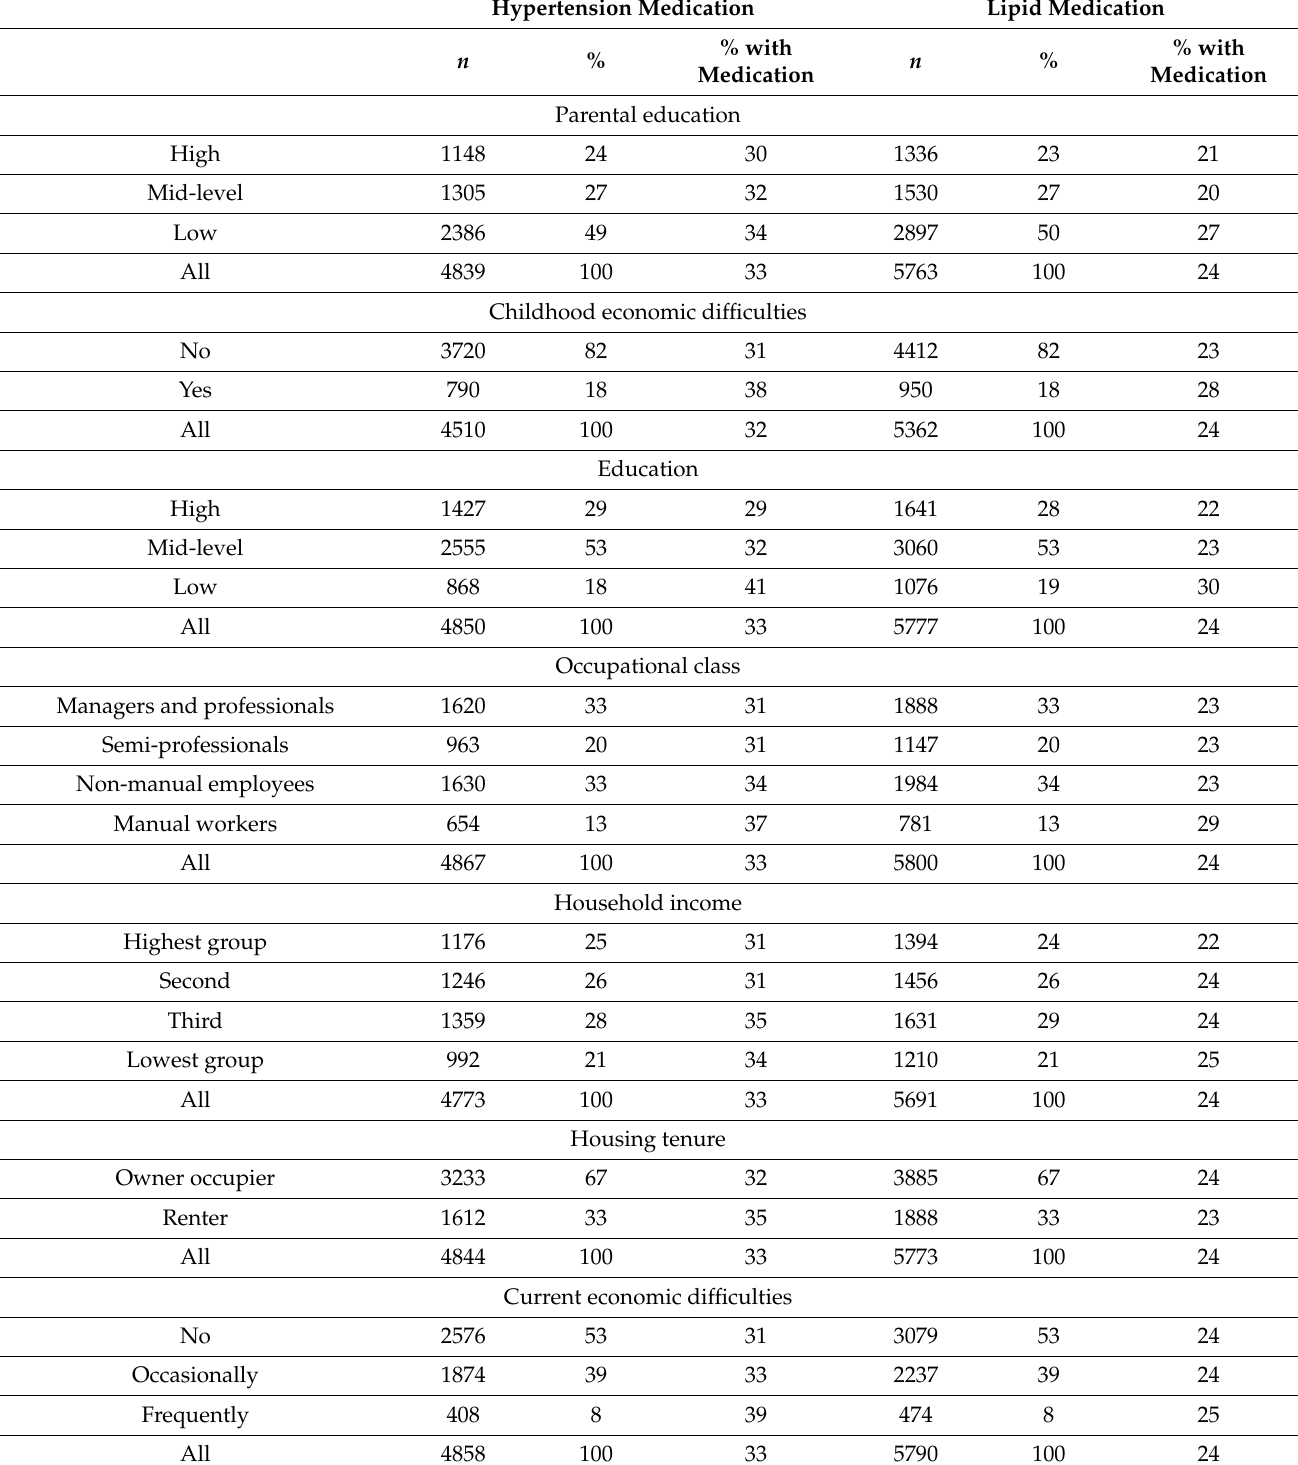
Table 1. Distribution of participants ( n , %) and prevalence (%) of cardiovascular medication by socioeconomic